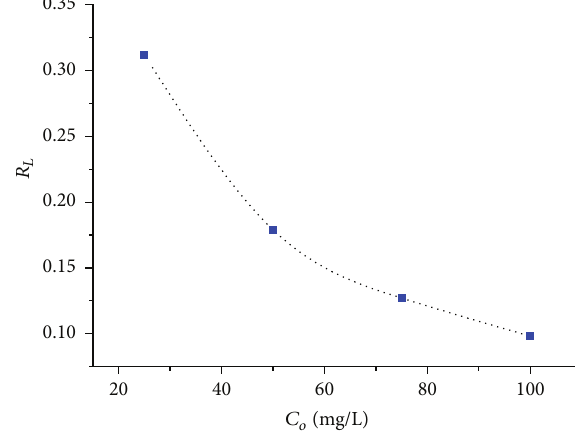
Figure 5: Effect of initial concentration and time on the sorption of Hg(II) at pH 6.0 and 1.0 g of Adulsa leaves powder.